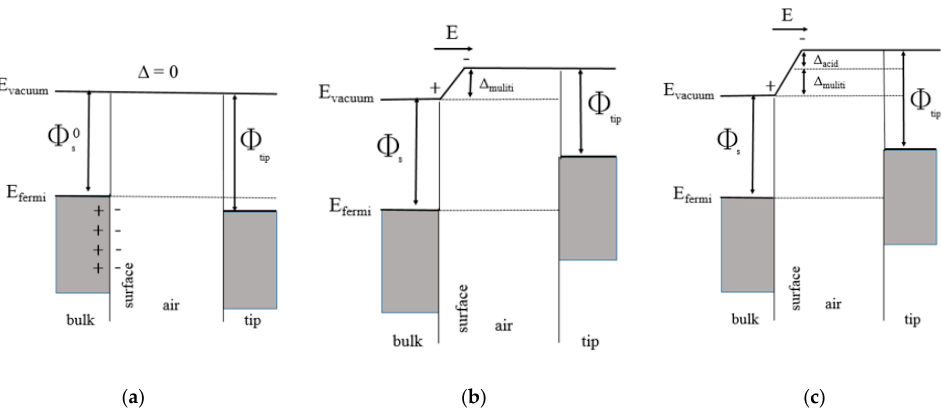
Figure 8. Schematic representation of the band diagrams during scanning Kelvin probe microscopy (SKPM) on PEDOT:PSS thin films. ( a ) aorbitol-treated PEDOT:PSS without PSS surface layer; ( b ) multilayer PEDOT:PSS with a PSS-rich surface layer; and ( c ) acid-treated PEDOT:PSS with a TFA ion-rich surface layer. φ 0 s , φ s and φ tips , are, respectively, the work functions of sorbitol-treated PEDOT:PSS thin film, multilayer “bulk” PEDOT:PSS, and the tip. ∆ multi and ∆ acid are the